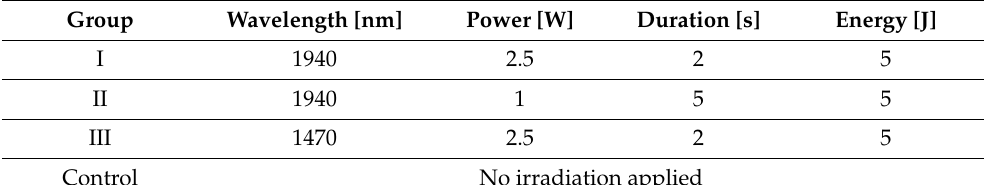
Table 1. Treatment groups (n = 6) with the different laser parameter combinations.